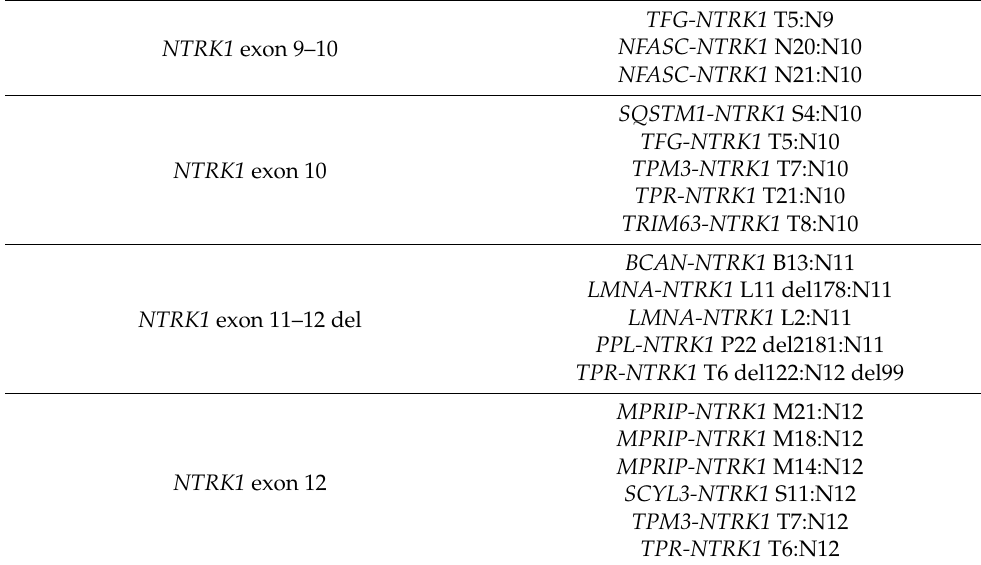
Table A1. List of detectable but not distinguishable gene fusions with the Easy PGX ready NTRK fusion